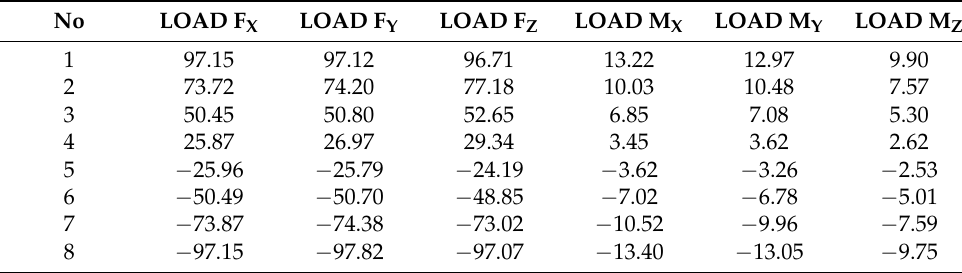
Figure 12. ATI AXIA 80 validated calibration jig. Table 8. Average force and moment reading of ATI AXIA.